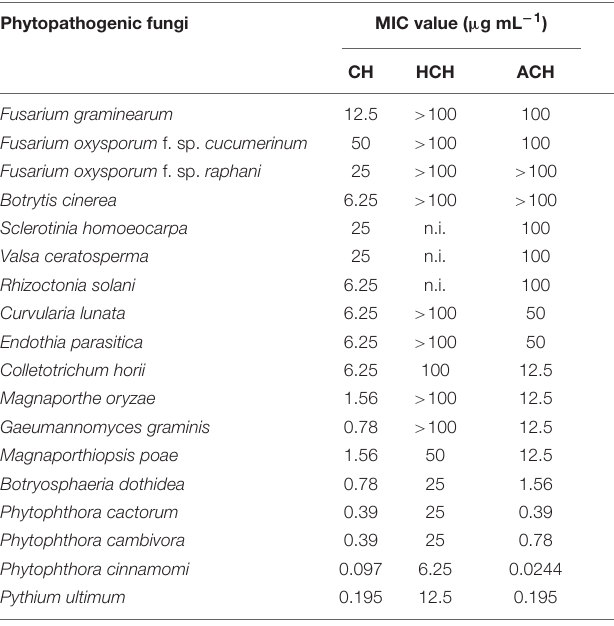
TABLE 2 | In vitro antifungal activity of cycloheximides against the mycelial growth of several phytopathogenic fungi. Phytopathogenic